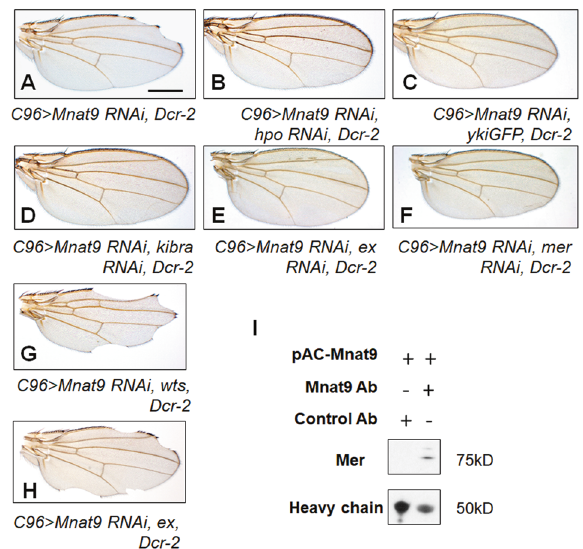
Fig. 3 Mnat9 RNAi phenotypes are suppressed by knockdown of Hippo pathway components. A C96 > Mnat9 RNAi causes wing notching. B – H Genetic interaction between Mnat9 RNAi and Hippo components. hpo RNAi ( B ) or yki overexpression ( C ) rescues Mnat9 RNAi phenotypes. Knockdown of kibra ( D ), ex ( E ), and mer ( F ) rescues Mnat9 RNAi phenotype. Overexpression of ex ( G ) or wts ( H ) enhances the Mnat9 RNAi phenotype. Scale bar: 0.5 mm. I Mer is co- immunoprecipitated with anti-Mnat9 antibody but not by control rabbit